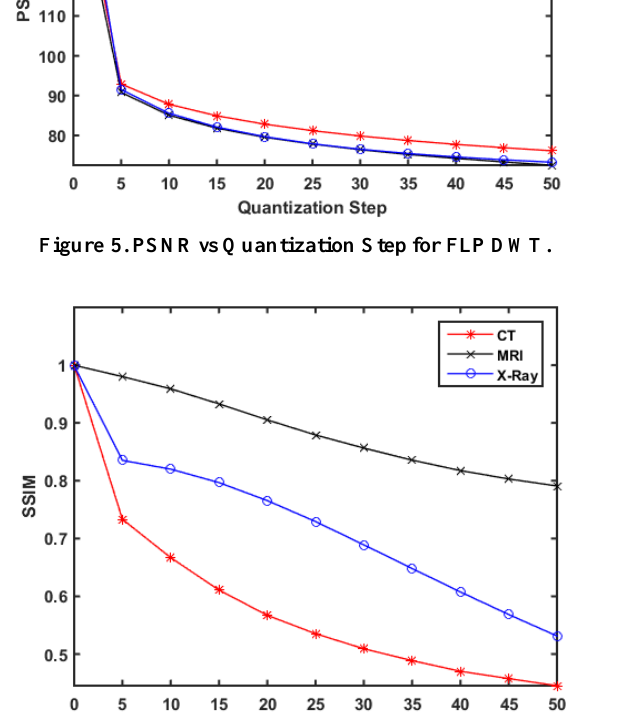
Figure 6. SSIM vs Quantization Step for FLP